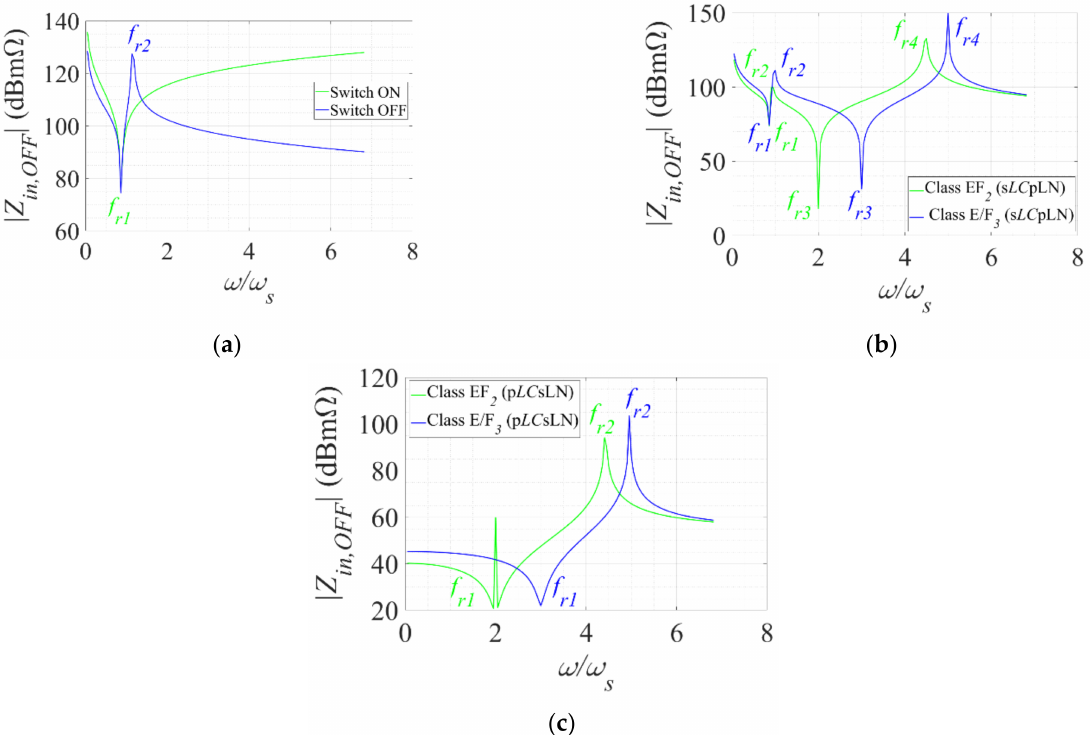
Figure 3. Input impedance ( Z in ) of ( a ) class E at switch ON and OFF conditions ( b ) class EF 2 and EF 3 at switch OFF condition ( c ) class E/F 2 and E/F 3 at switch OFF condition at V in = 50 V, D opt = 0.5, f s = 220 kHz, R L = R L,opt , k ≈ 0.30 (EF 2 ) and 0.67 (E/F 3